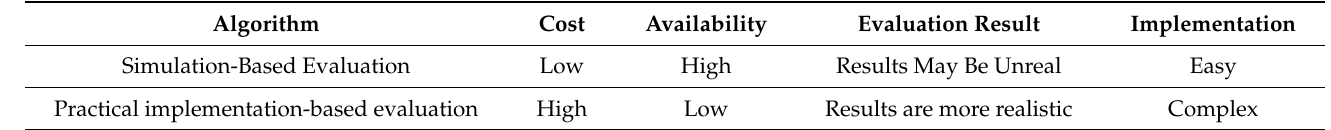
Table 7. Comparison of various evaluation